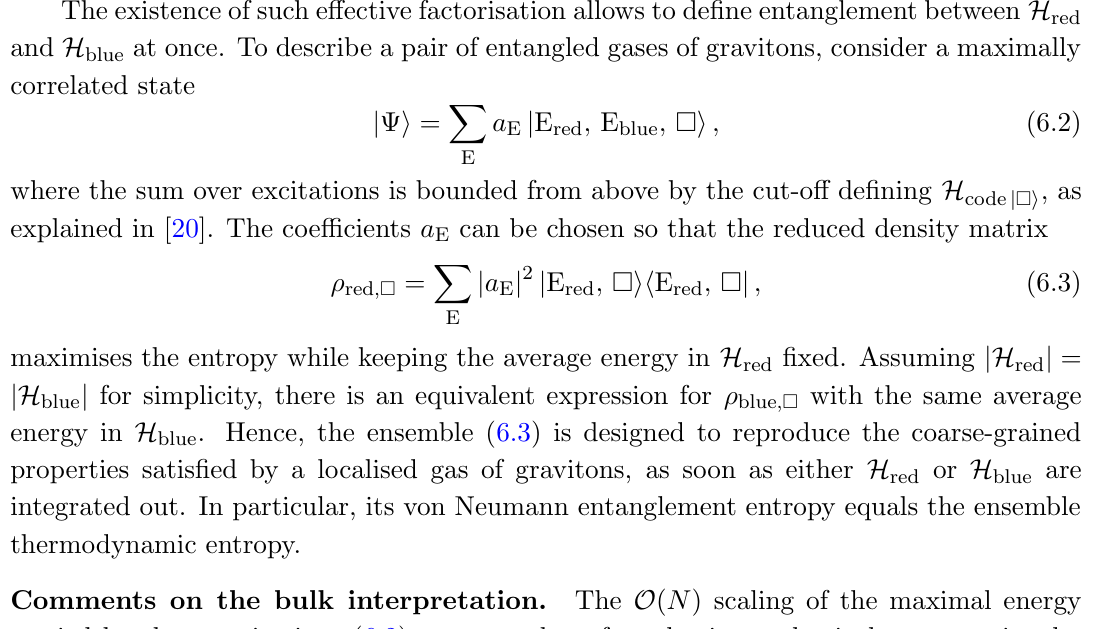
Figure 22 . Young tableau consisting of a reference state j (cid:3) i together with (at most) entangled graviton